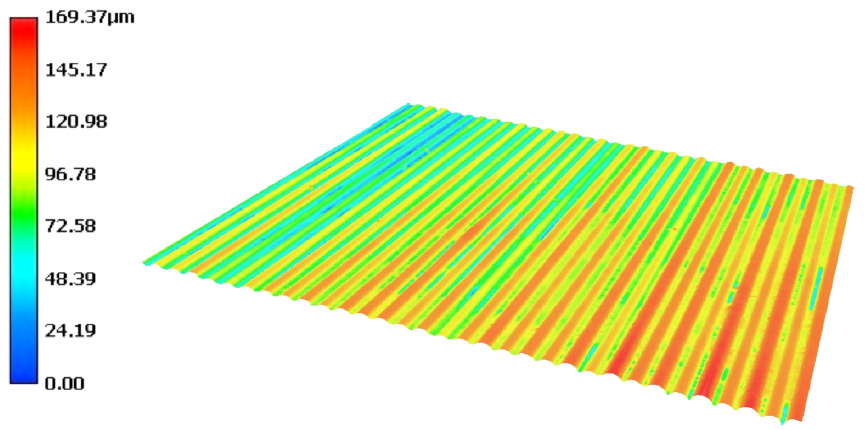
Figure 11. Surface topography in the header of the n14 distributor; the absolute value of roughness (0–169.37 µm) is skewed due to the curved shape of the header.